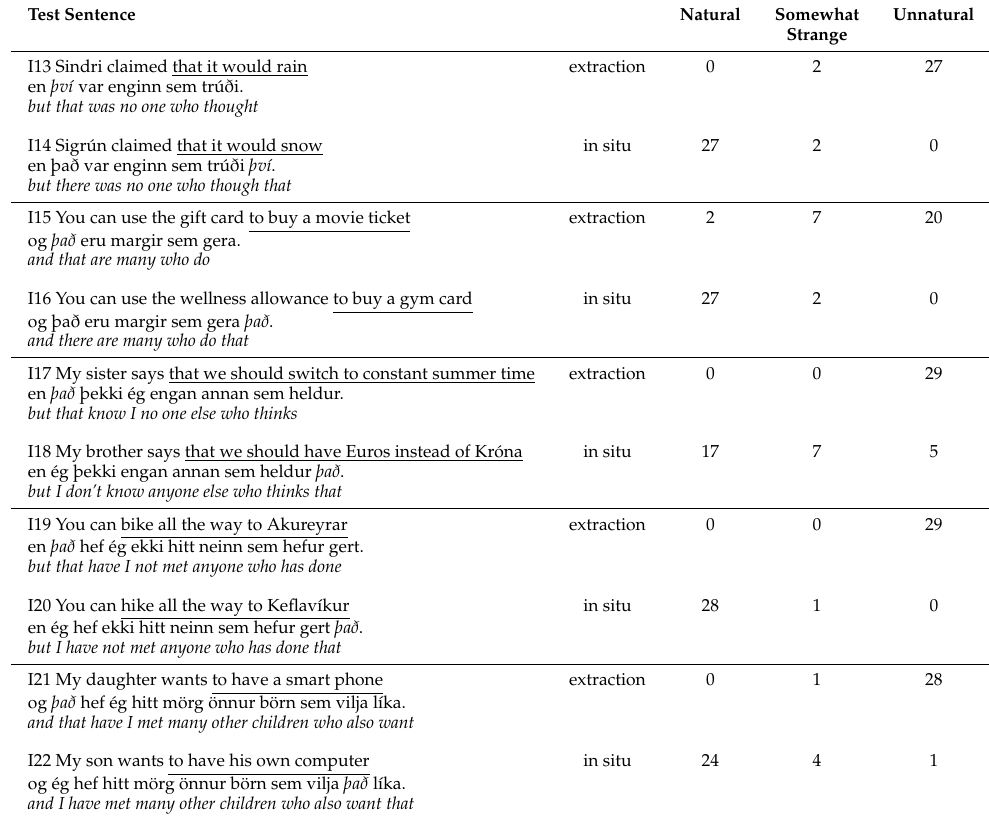
Table 4. Extraction from relative clauses: test sentences and judgments,